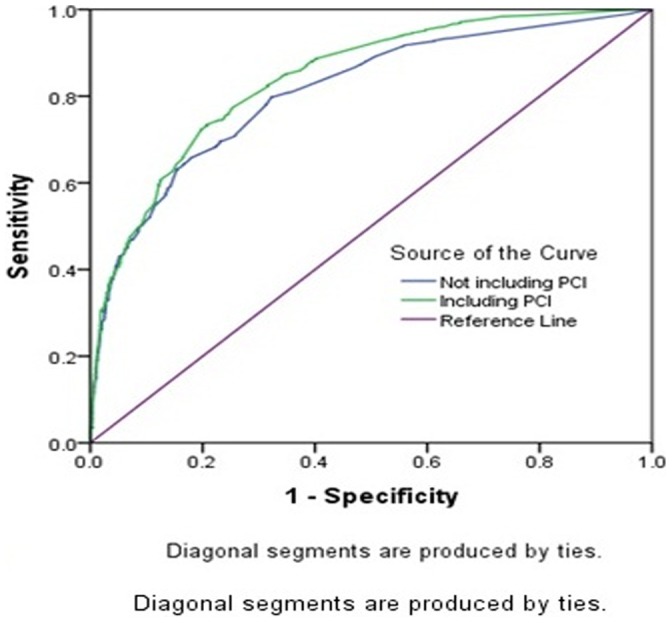
Receiver-operator characteristic curves (ROCs) of the predicting performance of PCI on 1 year mortality.The curves are constructed as in Fig. 1. The AUC for mortalities was 0.841(0.825–0.857) and 0.811(0.792–.0830) for the risk model with and without the PCI separately (both P<0.001).